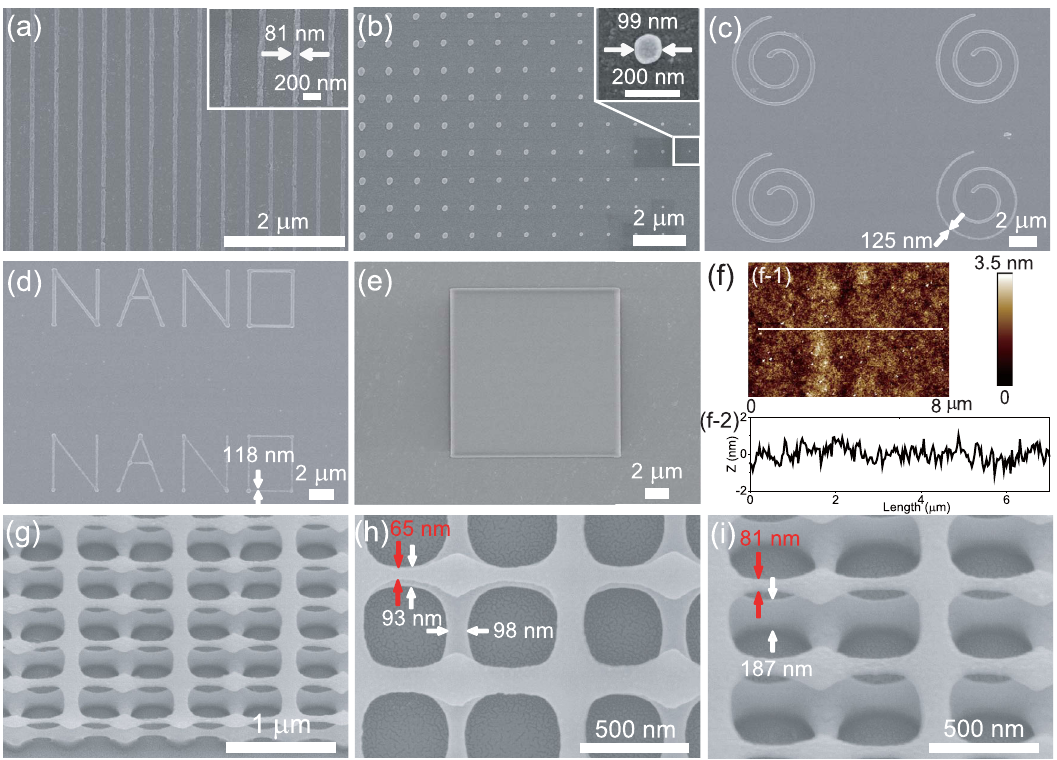
Fig. 4 2D and 3D HSQ features fabricated by FsLDW. a SEM image of nanowire array. The inset is the magni fi ed SEM image of the nanowire array. b SEM image of nanodot array. The inset is the magni fi ed SEM image of the nanodot. c SEM image of mircro-archimedes spiral array. d SEM image of micro- letters of NANO array. e SEM image of micro-square. f AFM measurement on the HSQ micro-square shown in e . f-1 AFM image of the micro-square. f-2 The pro fi le of the top surface of the HSQ micro-square shown in f-1 , exhibiting the roughness of about 3 nm. g 45°-tilted-view SEM image of the 3D double layered HSQ microstructure. Magni fi ed h top view and i 45°-tilted-view SEM images of the 3D HSQ microstructure. The feature sizes of the upper layer (red) and bottom layer (white) are shown in h and i